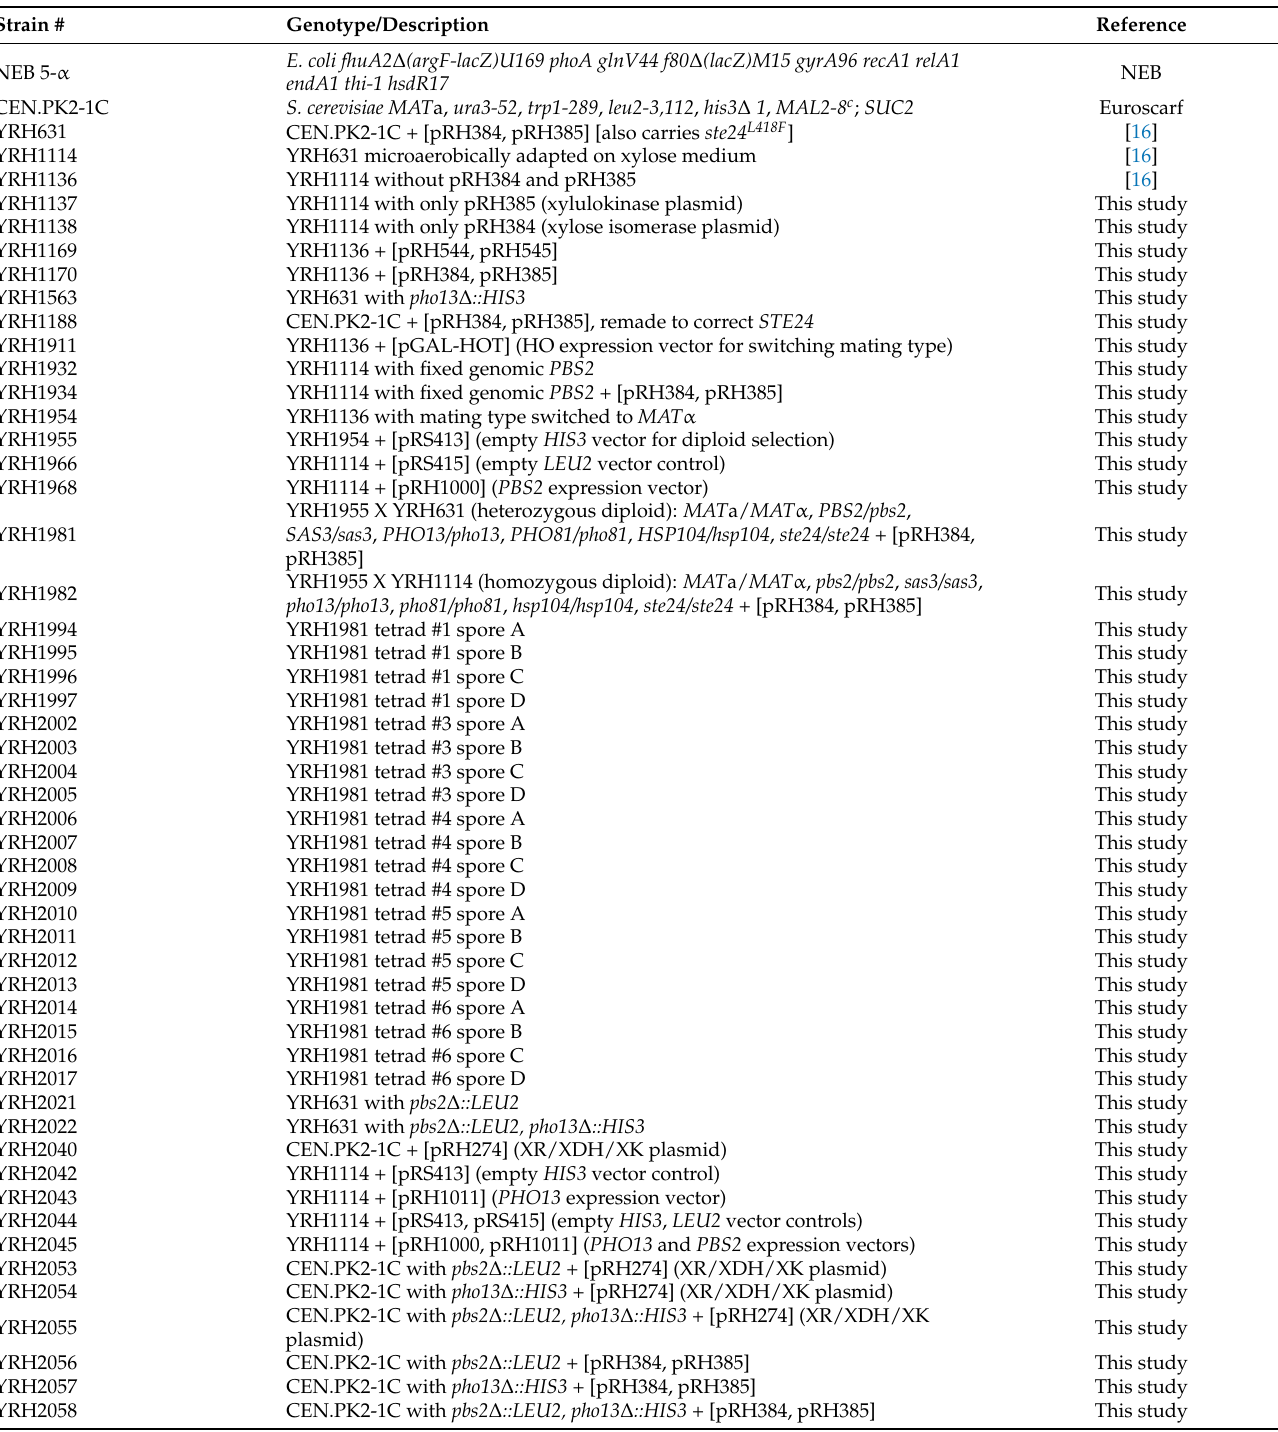
Table 2. Microorganisms used in this